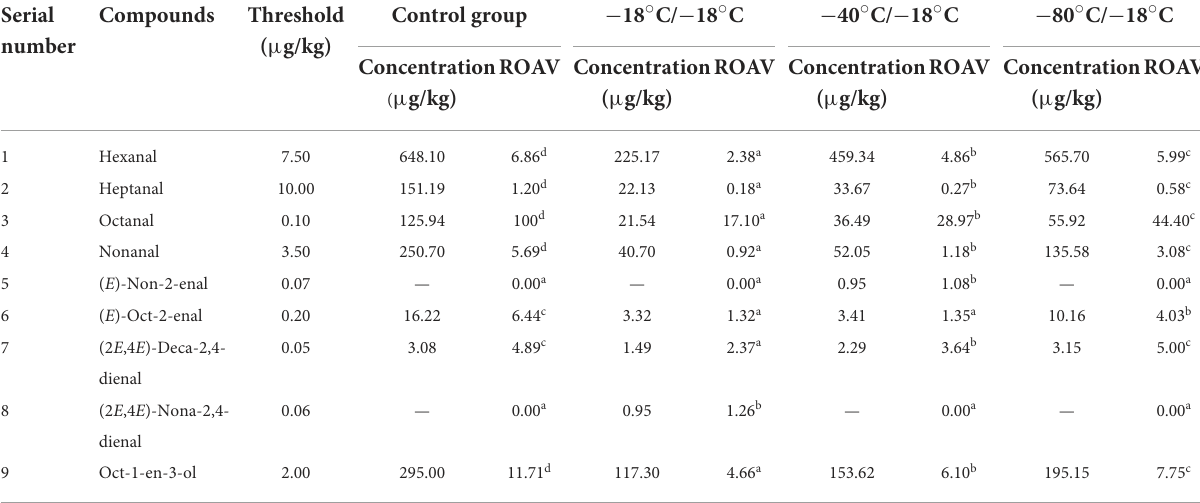
TABLE 3 Information on characteristic volatile compounds of HGM with different freezing